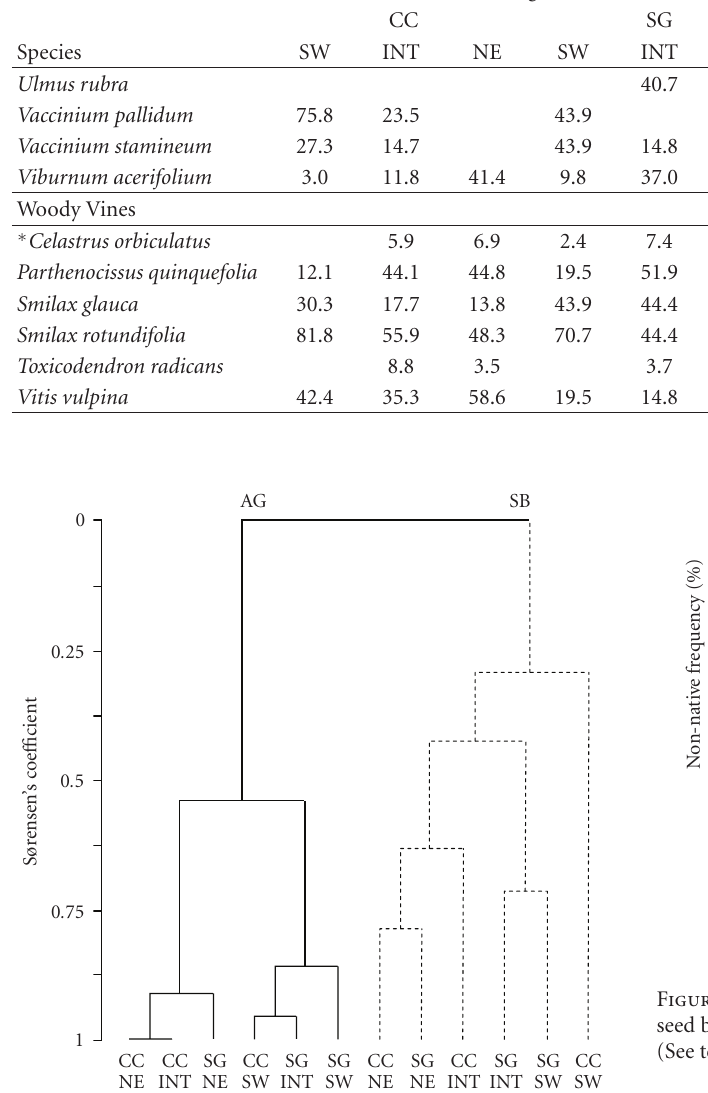
Figure 5: Summary dendrogram representing UPGMA cluster analysis of aboveground (AG; solid) and seed bank (SB; broken) samples across the six stand age/aspect classes examined. (See text for description of aspect/stand age classes.)